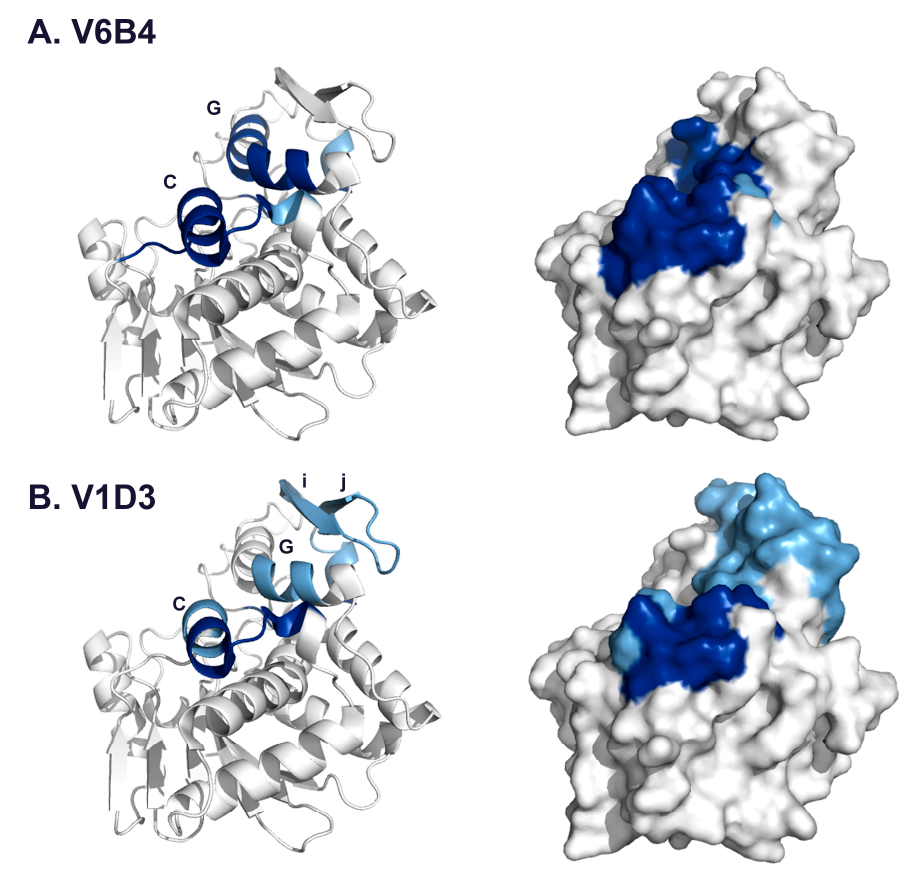
Figure 5. Epitope localization for two subcluster 3.1 V H Hs. HX protection categories shown in Figure 4 were mapped onto the crystal structure of RiVax for ( A ) V6B4 and ( B ) V1D3. The most relevant secondary structure elements, α -helices C and G and β -strands i and j, are labeled. The color shading corresponds to strong (deep blue), intermediate (light blue) or no significant protection (gray), as represented in Figure 4.